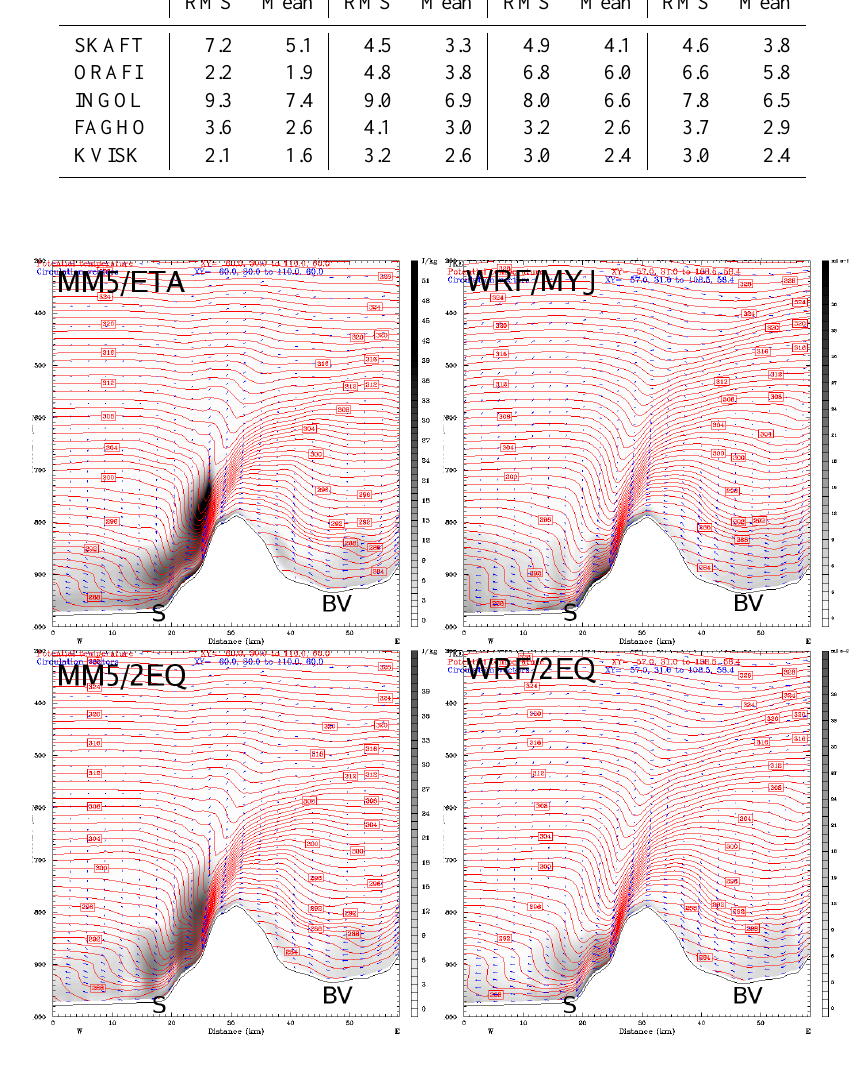
Figure 6: Cross section along line AB (cf. Fig. 4) showing potential temperature (red lines) [K], wind along the cross section (blue arrows) [ms − 1 ] and turbulent kinetic energy (TKE) [J/kg] for MM5 (left panels) and WRF (right panels) at 16 September 2004, 06:00UTC. Top panels show results from the ETA and MYJ boundary layer schemes and the bottom panel shows results using the new two equation PBL model. The letter “S” indicates the location of SKAFT and “BV” shows the location of the vertical profile, along which the Brunt-Väisälä frequency in Table 4 is calculated.